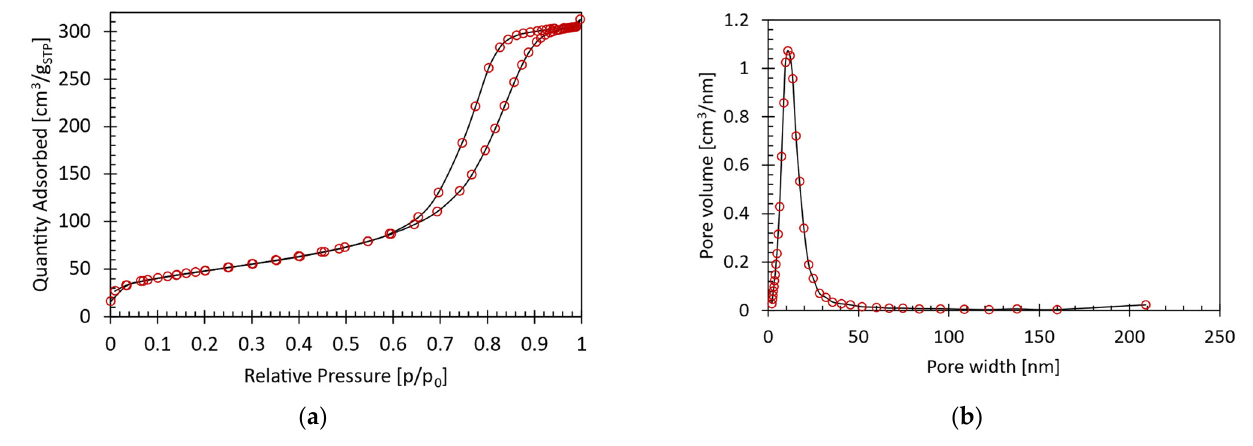
Figure A1. Volume of N 2 adsorbed/desorbed as a function of the relative pressure (P/P 0 ) ( a ) and pore volume as a function of the pore width ( b ), as derived from the BJH elaboration of the desorption branch.